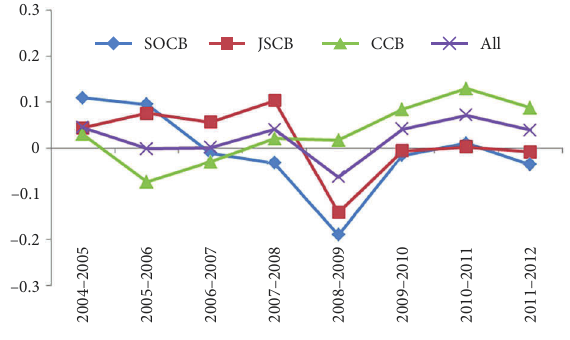
Figure 6. TCG change: